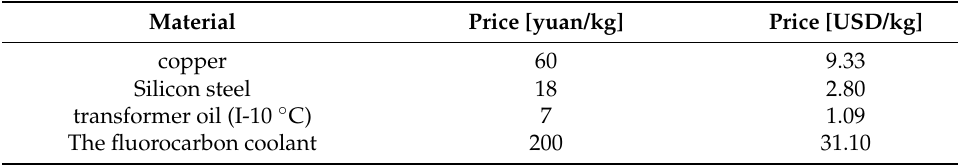
Table 3. Main material price of transformer.